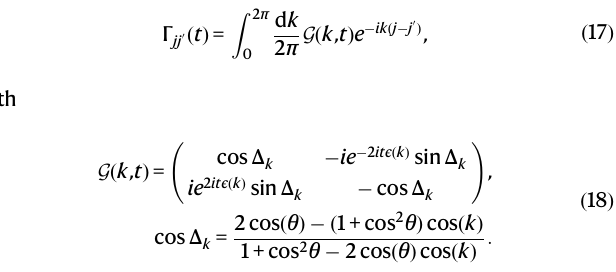
and boundary conditions in the evolution Hamiltonian H . In panels a and b , J 2 =0, and H corresponds to the XXZ spin chain with anisotropy parameter Δ ; in both cases, we take PBC for the chain. In panels c and d , J 2 =1, and the chain is non- integrable; in panel c , we consider PBC while in panel d we choose OBC with the subsystem A placedinthemiddleofthechain.SourcedataareprovidedasaSource Data fi